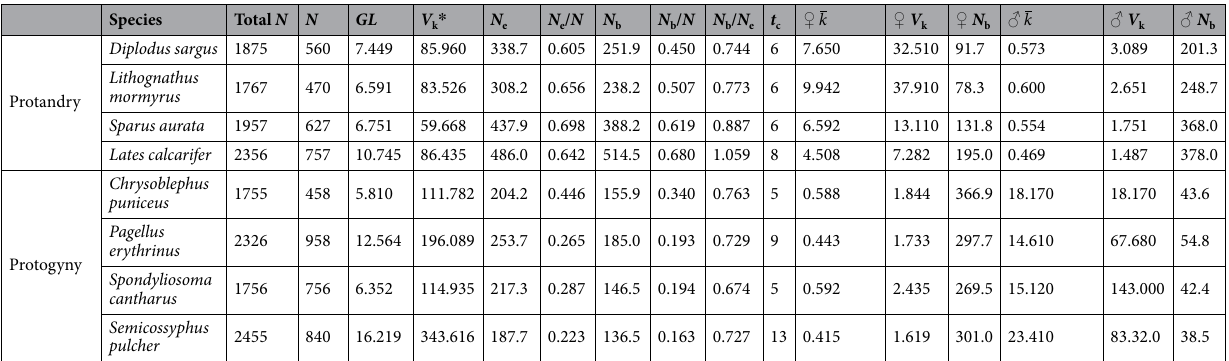
Table 2. Estimates from AgeNe and used value of age at sex change ( t c ) for each species. Total N : estimated number of individuals in the population; N : estimated number of adult individuals (adult census size); GL : estimated generation length; V k * : lifetime variance in reproductive success; N e : effective population size; N b : effective number of breeders per year; k : annual mean number of offspring; ♀ : female; ♂ : male. The last six columns report k , V k and N b , per sex, per breeding